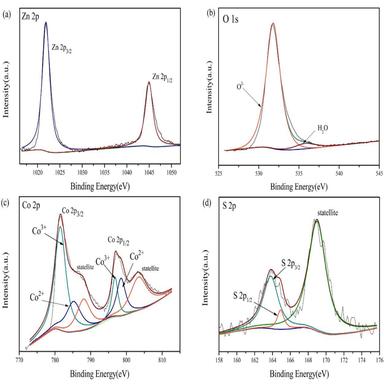
High-resolution XPS spectra of (a) Zn 2p, (b) O 1 s, (c) Co 2p and (d) S 2p.